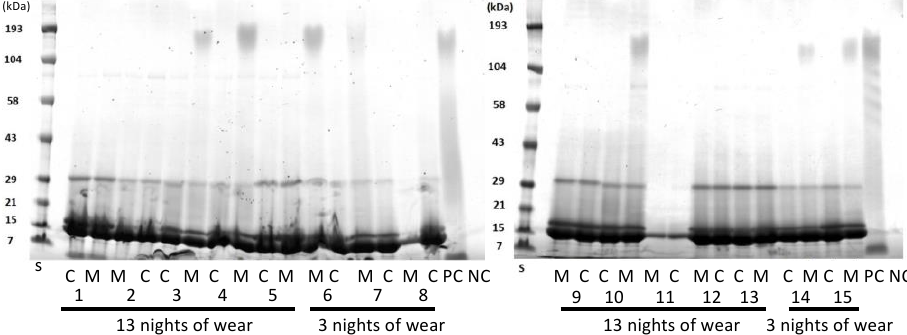
Figure 3. SDS-PAGE of extracts from worn etafilcon A contact lenses. C = control lenses; M = Mel4-coated lenses; numbers on the x-axis denote different patients. S = standards of known molecular mass.